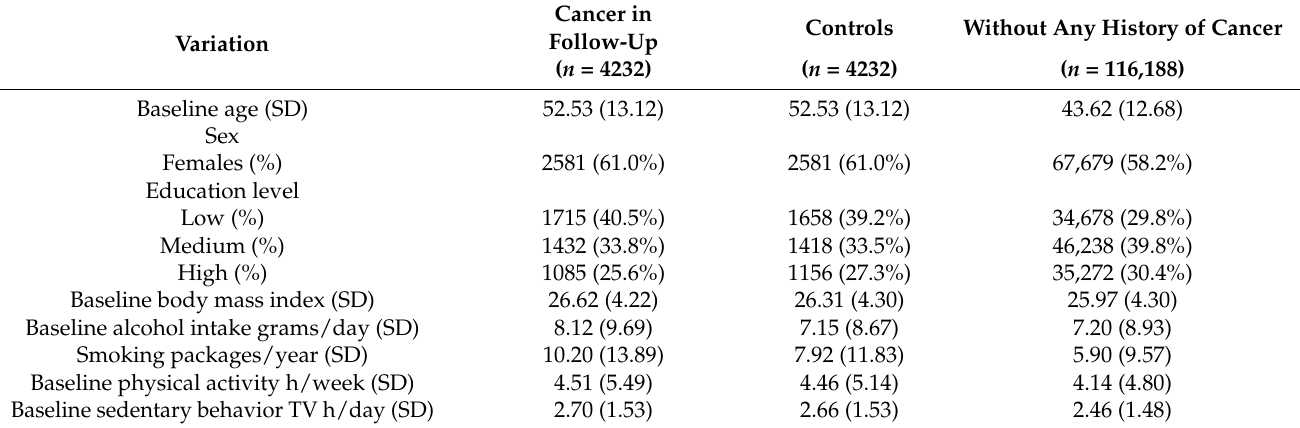
Table 1. Baseline characteristics of the 120,420 participants stratified by those who had a new cancer diagnosis in the follow-up versus those without any history of cancer (for age and sex-matched controls and the others without any history of